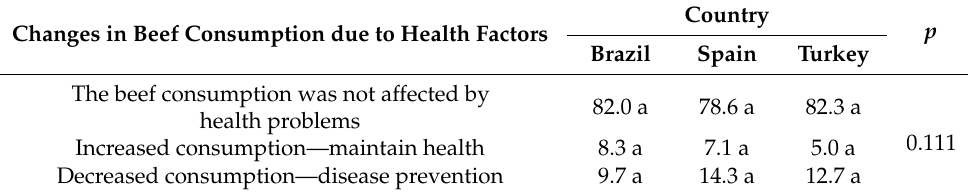
Table 7. Changes in beef consumption due to health